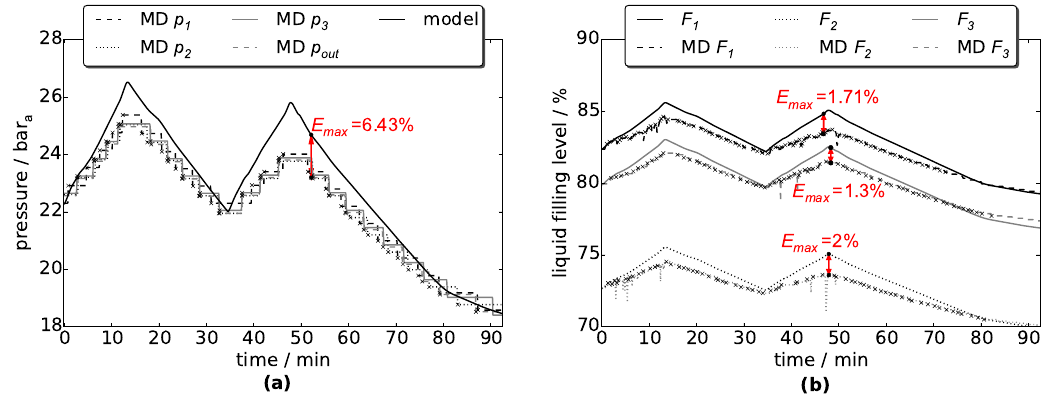
Figure 10. Example 1; MD denotes the operational measurement data; 1, 2 and 3 denote the different storage vessels. ( a ) Pressure inside the storage vessels; the model denotes the simulation results; out denotes the pressure inside the collecting pipe connected to the discharging pipes of the three storage vessels. ( b ) Liquid filling level inside the storage